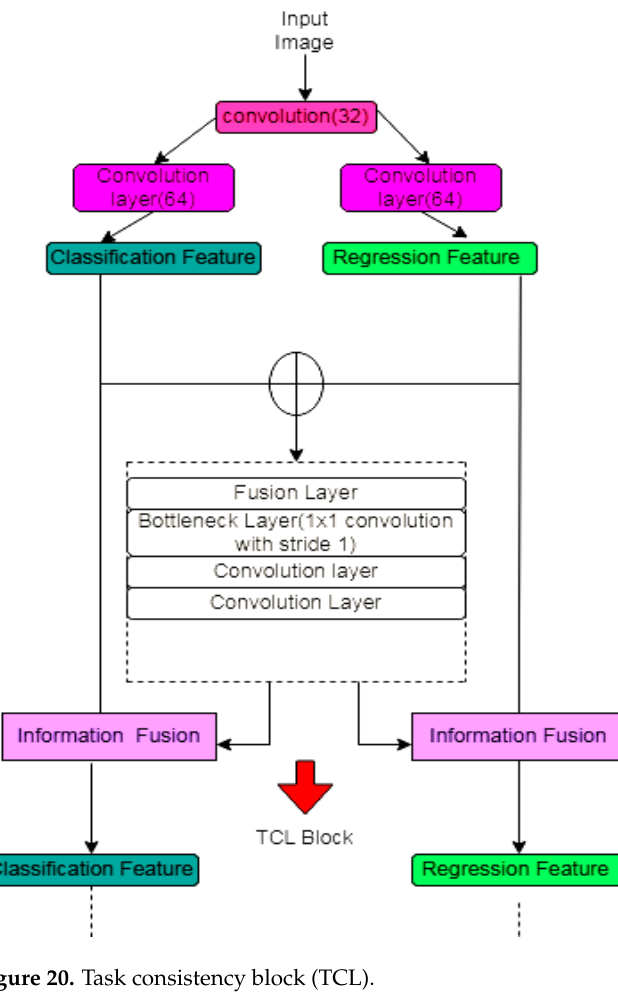
Figure 20. Task consistency block (TCL).